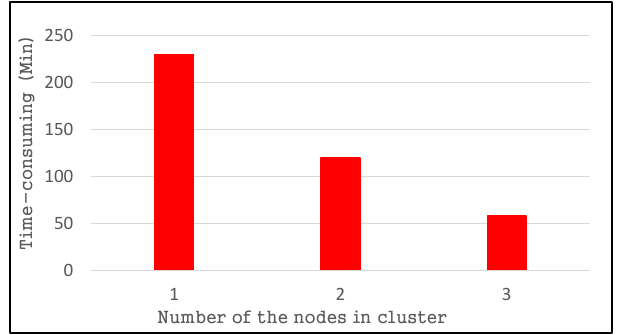
Figure 12. The query performance comparison between the different node numbers.